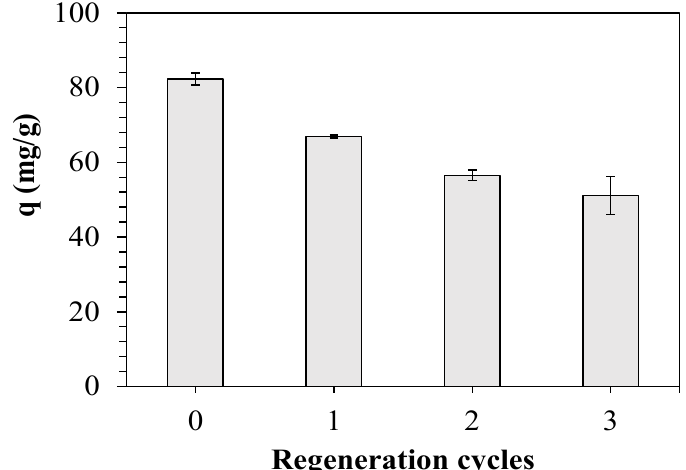
Figure 9. Cu(II) adsorption dependence on number of regeneration cycles. Here, q denotes the adsorption capacity.